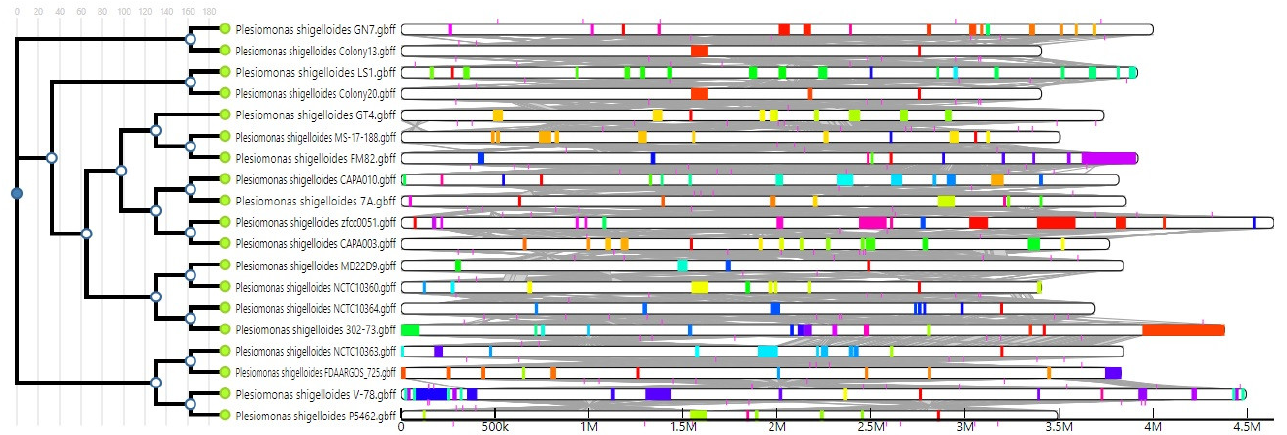
Figure 4. Genomic islands encoded in 19 Plesiomonas genomes.